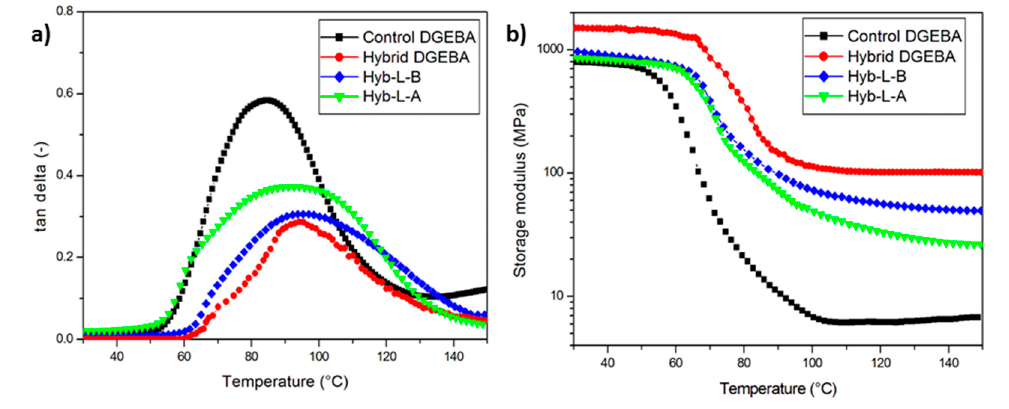
Figure 5. Results (( a ) tan δ and ( b ) storage modulus) of the hybrids cold-cured in presence of PACM TETA hardeners and of the Control or TETA hardeners and of the Control DGEBA.